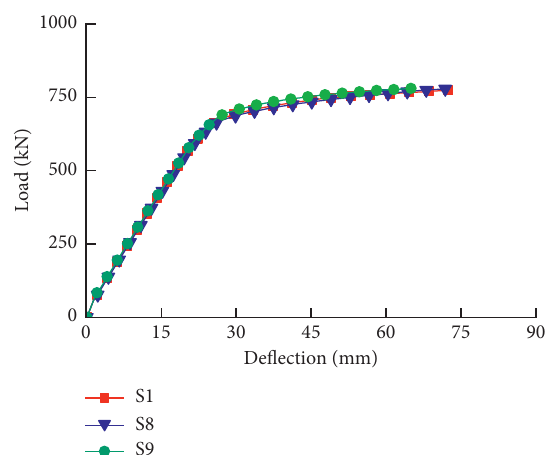
Figure 11: Load vs. midspan deflection with different initial ef- fective prestress.